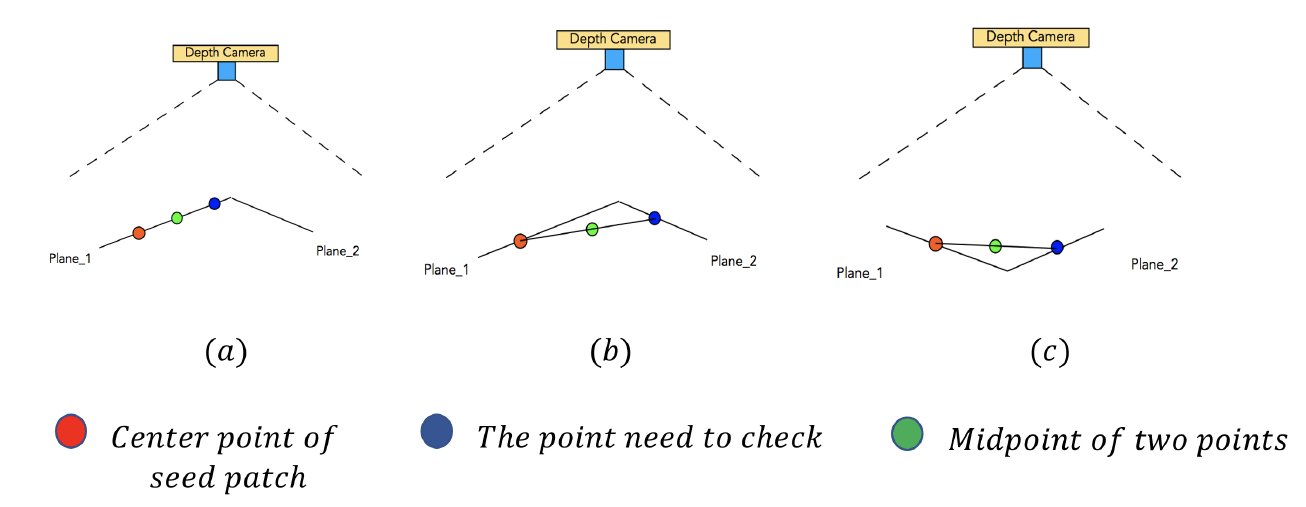
Figure 9. Cross section of overgrowing cases: ( a ) undergrowing; ( b ) overgrowing and convex to the camera; ( c ) overgrowing and concave to the camera.